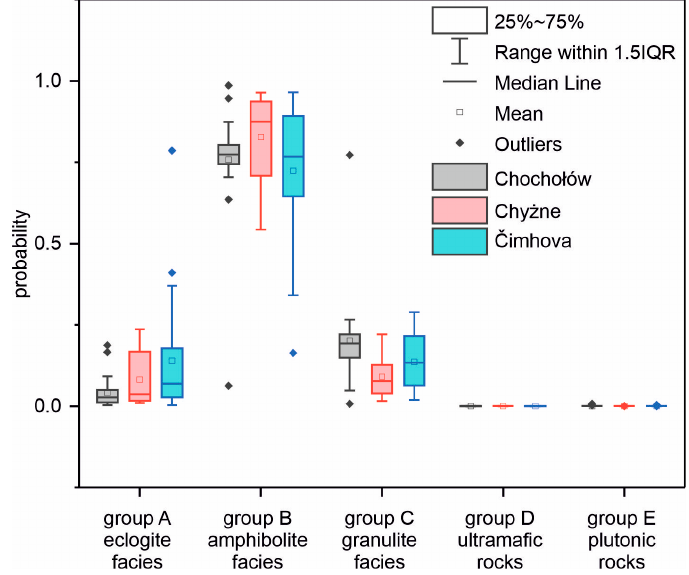
Figure 11. Box plot showing the distribution of the calculated probabilities for the studied garnet provenance regarding source rock and facies groups. Probabilities calculated according to Tolosana-Delgado et al. [71].